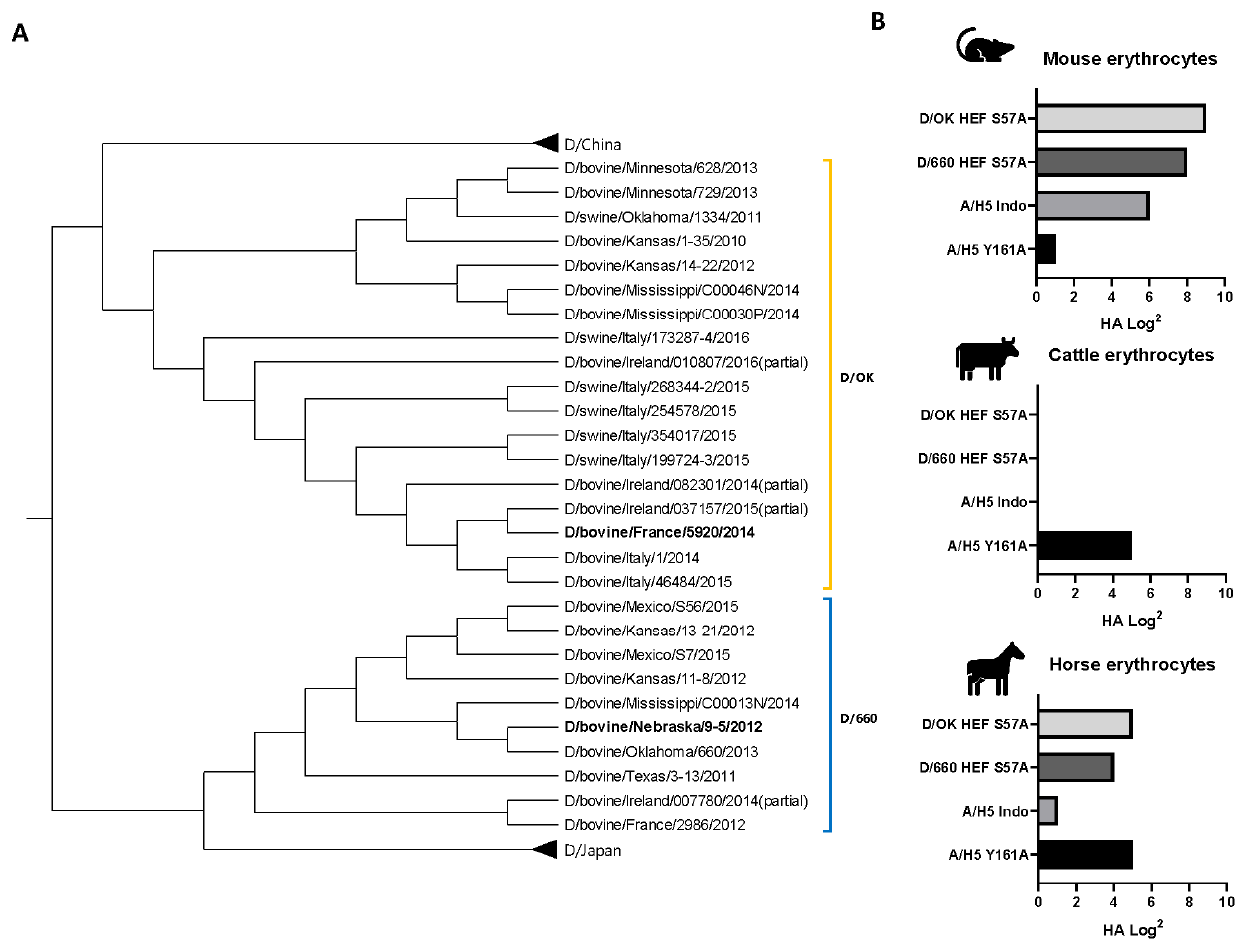
Figure 2. ( A ) Phylogenetic tree of influenza D HEF protein gene. Sequences are listed by country, species isolated, location, and year of isolation. The genes are clustered into D/OK or D/660 clades. The two strains used in this research have been highlighted in bold. ( B ) Hemagglutination assays comparing the protein binding avidity of both D/OK and D/660 HEF S57A proteins in mouse, cattle, and horse erythrocytes along with two H5 HA proteins A/H5 Indo and A/H5 VN Y161A as controls.